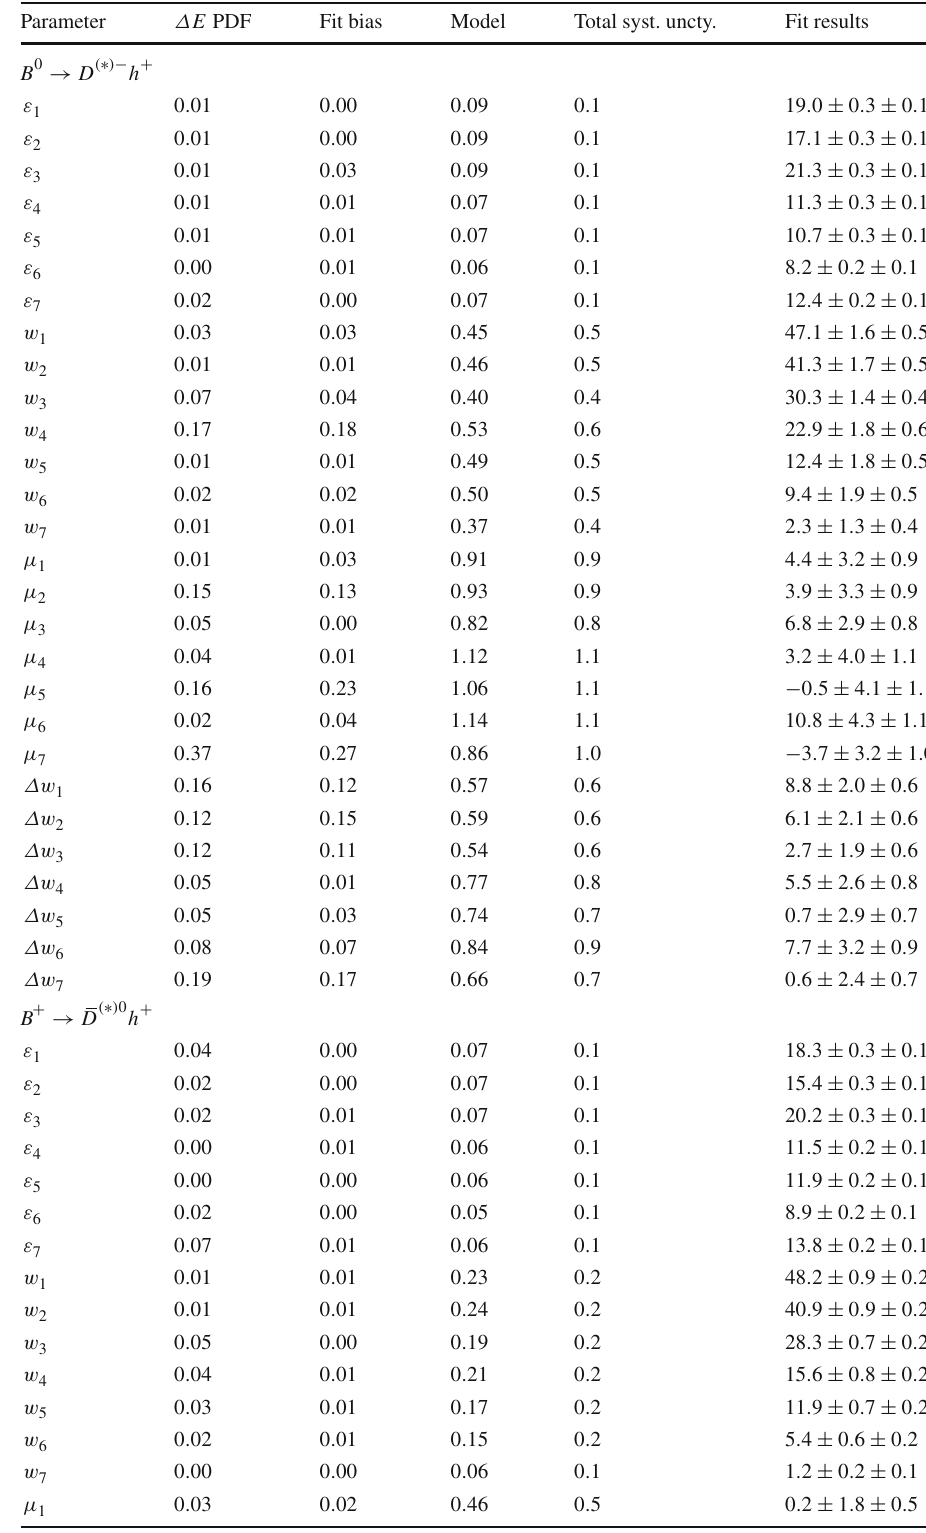
Table 5 Results for ε i , w i , μ i , and Δw i for the category-based (FBDT) tagger: systematic uncertainties associated with the Δ E parametrization, fit bias, and fit model, and total systematic uncertainty are shown together with the fit results (with stat. and syst. uncertainty). The results are given in